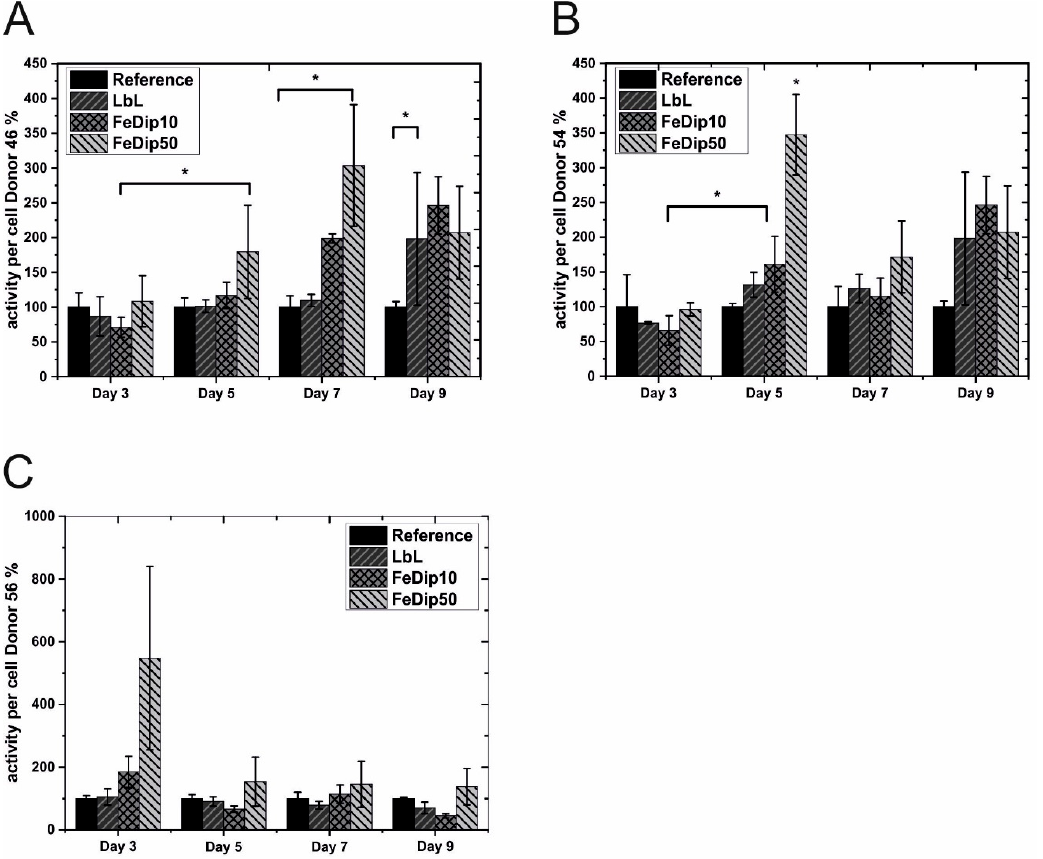
Figure 5. Relative Metabolic activities of the used hMSC cells from ( A ) Donor 46, ( B ) Donor 54, and ( C ) Donor 56 was determined at four different time points for the particular surface modifications in relation to cells grown on reference substrates. All experiments were performed in triplicate. * p < 0.5 (analyzed by one-way ANOVA with Tukey test).